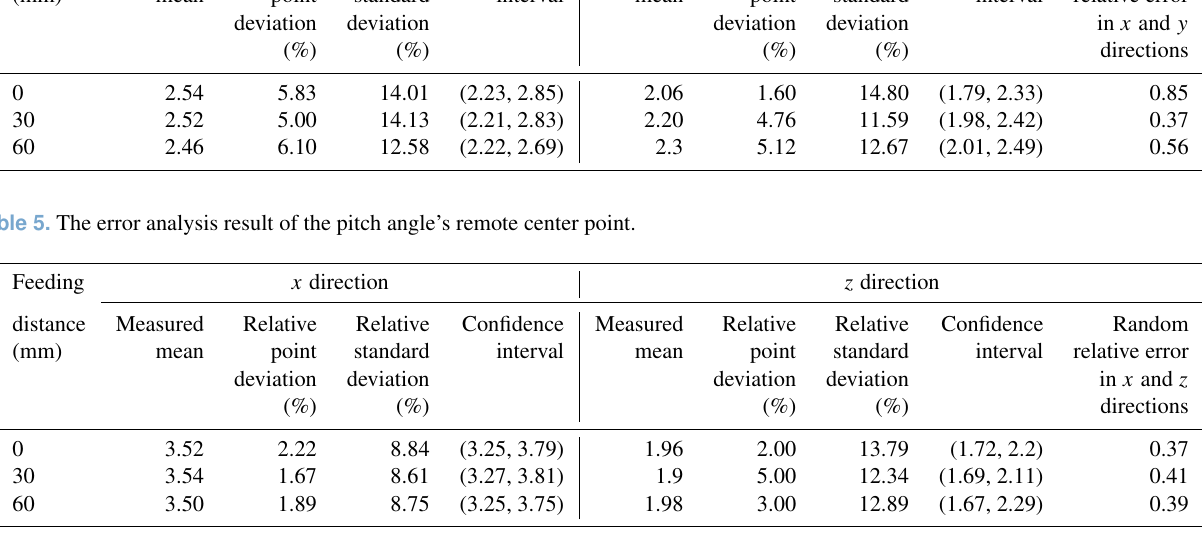
Table 4. The error analysis result of the yaw angle’s remote center point. Feeding x direction y direction distance Measured Relative Relative Confidence Measured Relative Relative Confidence Random (mm) mean point standard interval mean point standard interval relative error deviation deviation deviation deviation in x and y (%) (%) (%) (%) directions